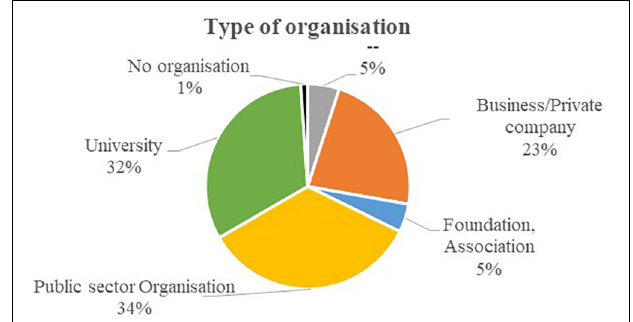
FIGURE 6 | Type of organisation of respondents.